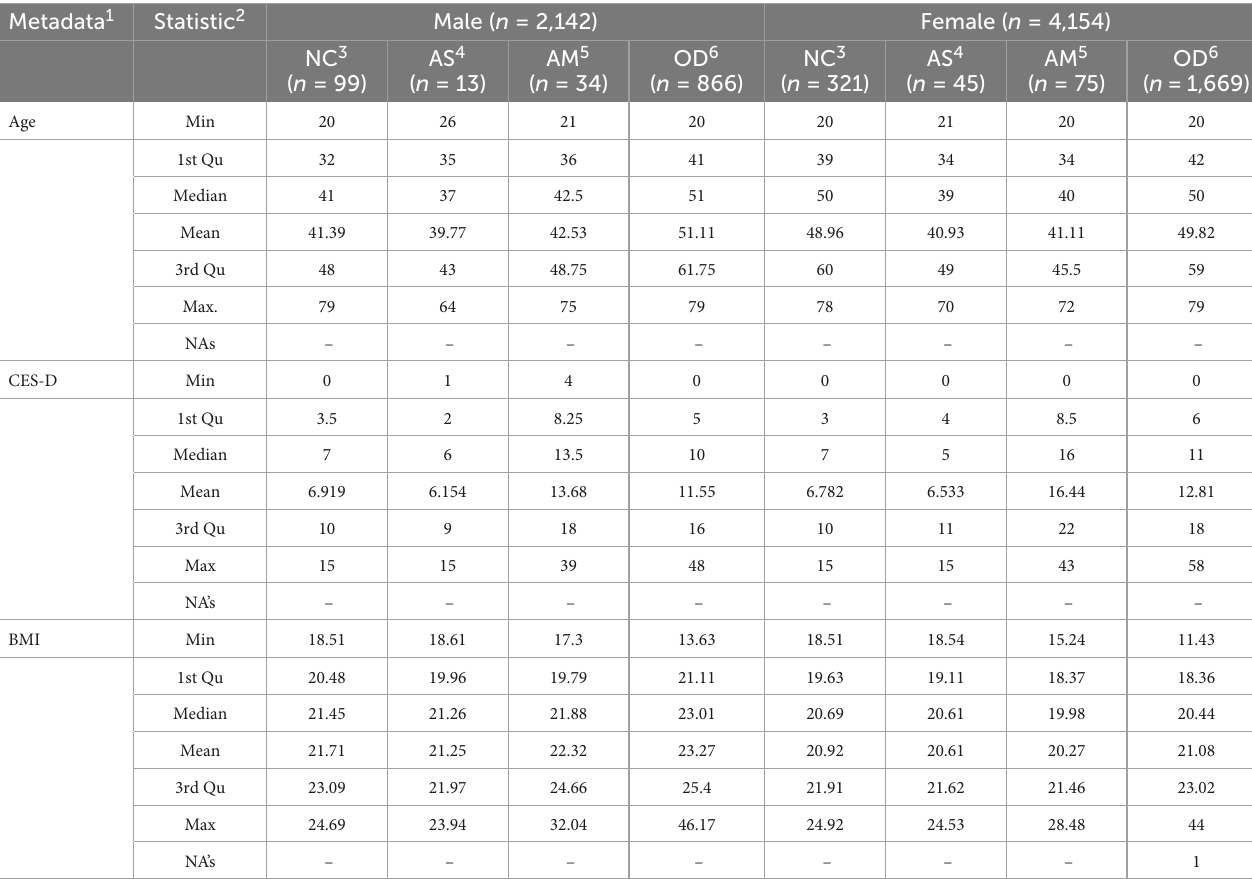
TABLE 1 Age, Center for Epidemiologic Studies Depression scale, and body mass index distributions for the analyzed groups. Metadata